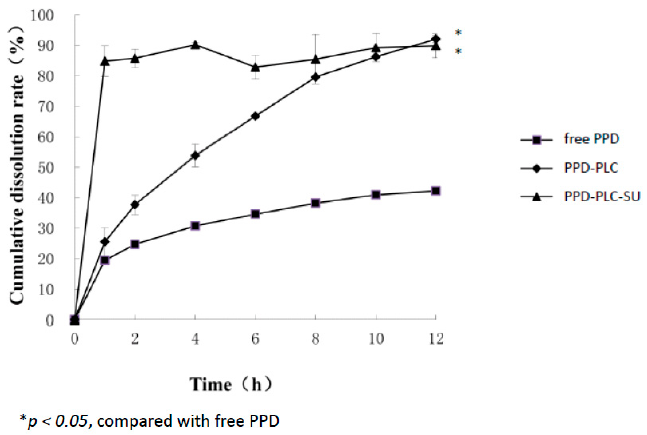
Figure 10. Comparative dissolution profiles of free PPD, PPD-PLC and PPD-PLC-suspension (SU) ( n = 3, mean ± SD).